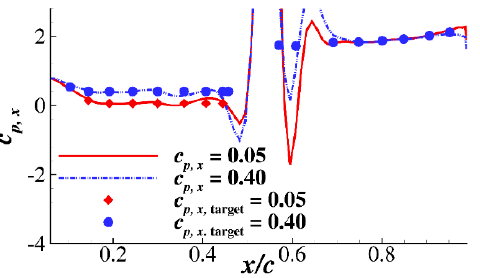
( b ) Figure 13. Geometries and pressure distributions of the airfoils ( Ma = 0.73, Re = 6.5 × 10 6 , C L = 0.800). ( a ) Airfoil geometries; ( b ) pressure distributions. Figure 14 shows the pressure gradients on the upper surfaces of the airfoils of c p,x = 0.05 and 0.40.